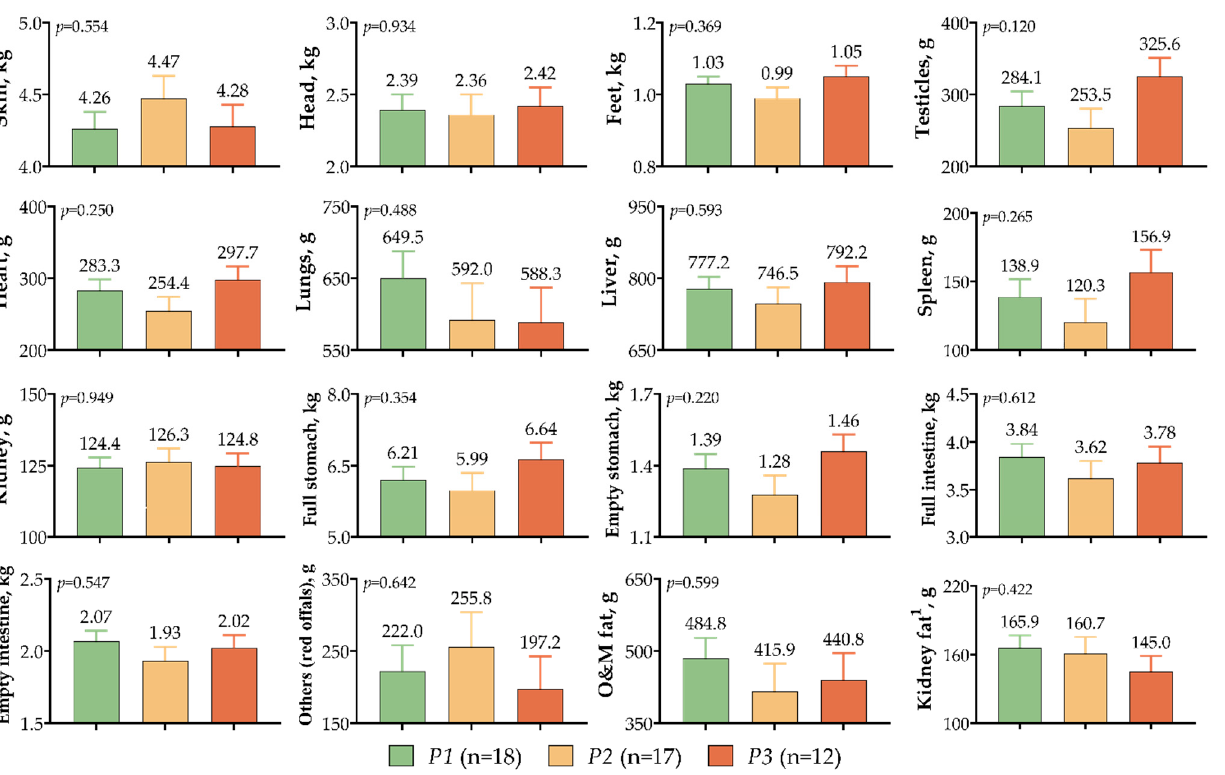
Figure 5. Effect of GHE5 polymorphism on non-carcass components in meat-type lambs. O and M fat: Omental and mesenteric fat. 1 weight after chilling at 4 °C for 24 h.